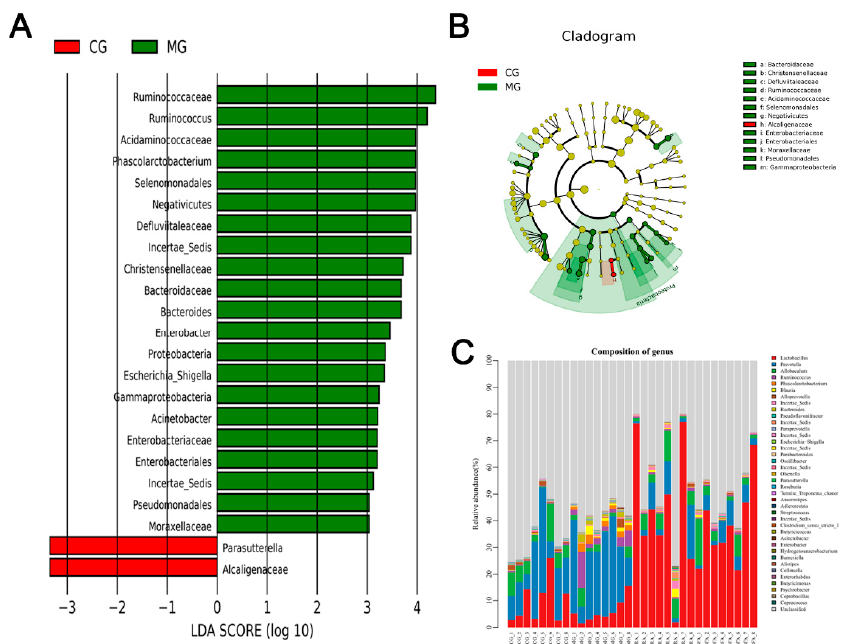
Figure 5. Identification of biomarkers of spleen-deficiency syndrome (SDS) and the abundance comparison of intestinal microbiota at the genus level among diverse groups: ( A ) Histogram of linear discriminant analysis effect size (LEfSe) analysis between the control group and model group. ( B ) Cladogram of LEfSe analysis. ( C ) Histogram of bacterial flora distribution at the genus level in each sample. Species that could not be annotated were classified into the ‘unclassified’ category.